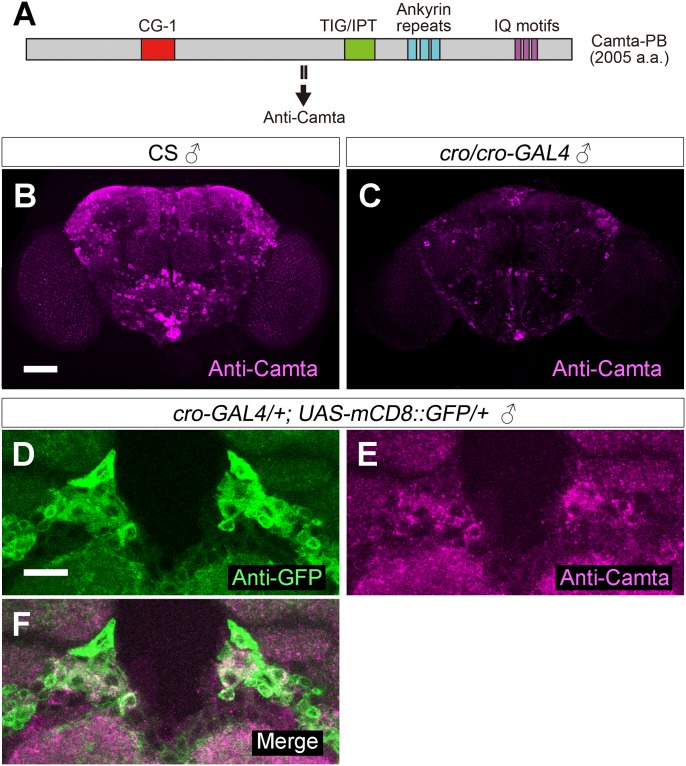
Expression of cro-GAL4 recapitulates endogenous Camta expression.(A) The antibody recognizes a unique sequence in Camta, whose domain structure is schematically illustrated. (B and C) The entire brain stained positive for Camta in wild-type (B) and cro/cro-GAL4 (C) males. (D-F) High magnitude images of the periesophageal region highlight cell bodies doubly positive for GFP (D and F: cro-GAL4, green) and Camta (E and F, magenta). Scale bars: 50 μm (B; also applicable to C) or 10 μm (D; also applicable to E and F).